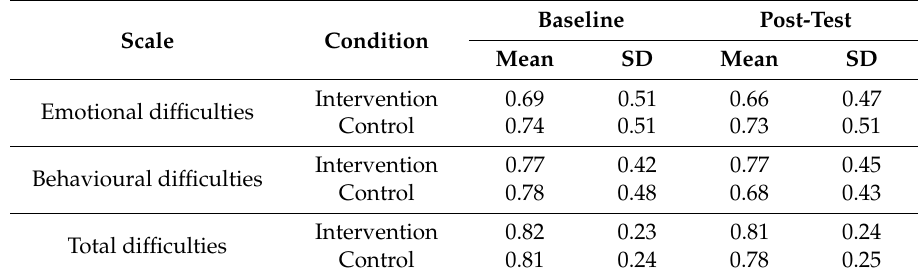
Means and standard deviations for SDQ strengths and difficulties scales by experimental